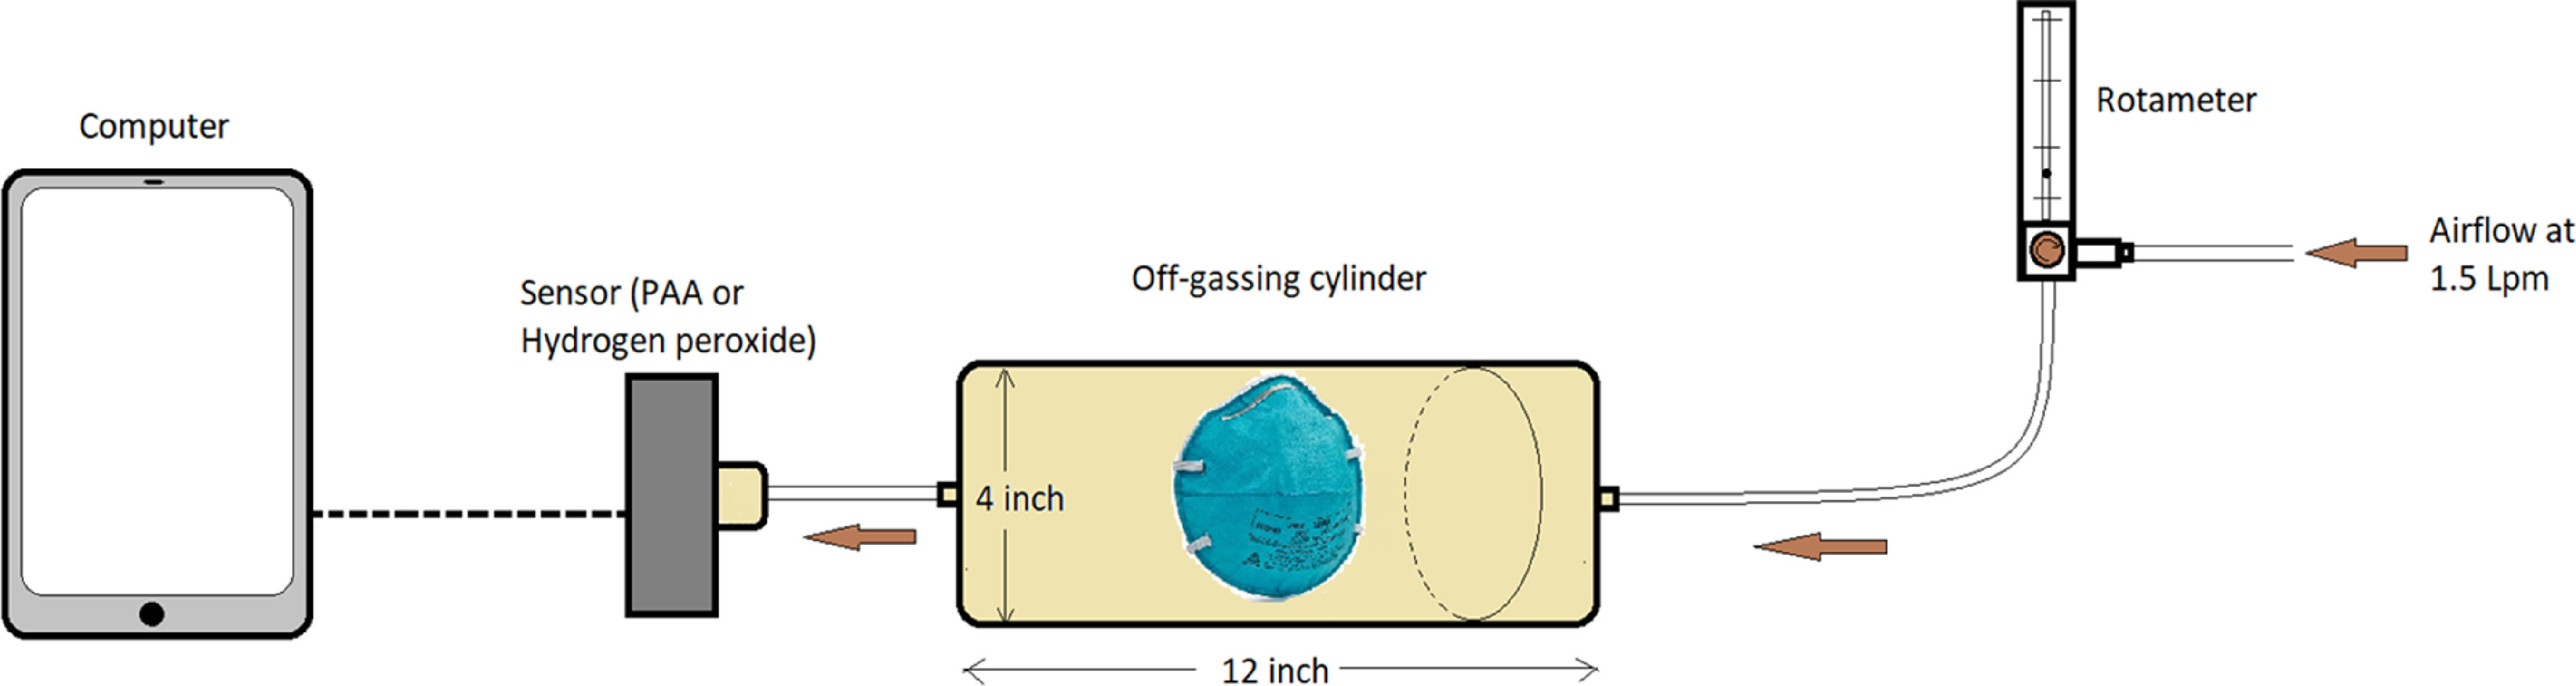
The off-gassing set up. The N95 FFR was placed in a sealed polyvinyl chloride cylinder (0.35 cu. ft.) with airflow at 1.5 L/minute entering through one end and a peracetic acid or hydrogen peroxide sensor (Safecide, ChemDAQ, Pittsburgh, PA) connected to the other end. A 15-minute time-weighted average (TWA) for peracetic acid or hydrogen peroxide exposure was measured.